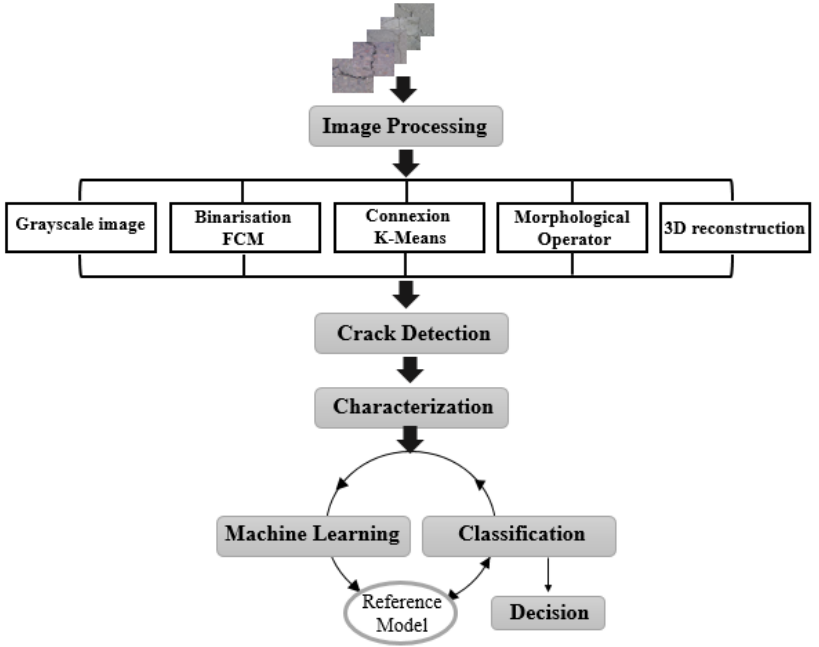
Figure 2. Block diagram of the crack detection and classification